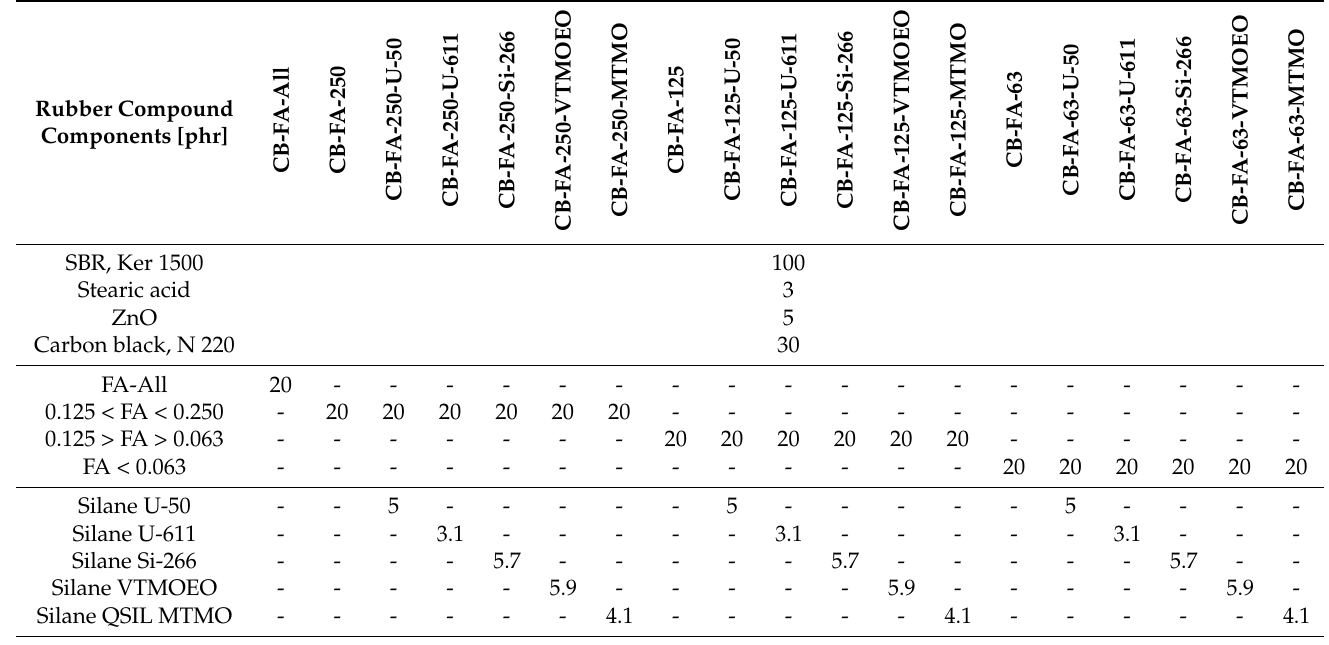
Table 2. Formulation of the rubber mixes filled with CB, fly ash, and silanes